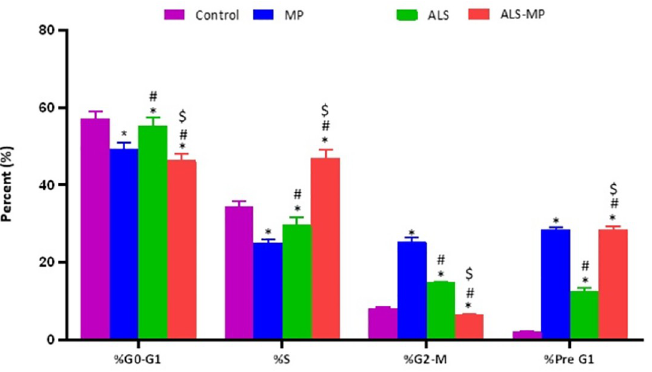
Fig 5. Effect of various formulations on cell cycle. � Significantly different from control p < 0.05, #significantly different from MP p < 0.05, $significantly different from ALS-Raw p < 0.05.